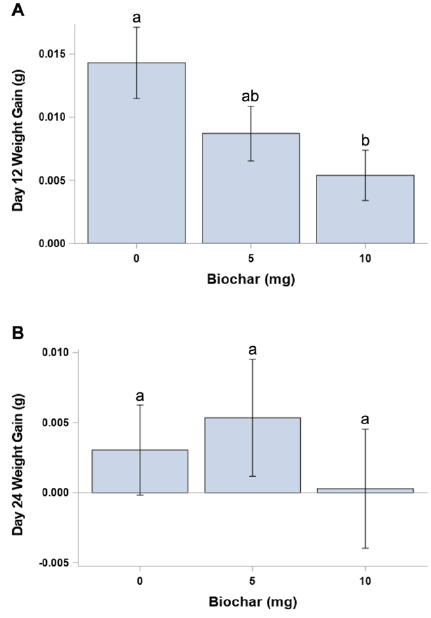
Figure 3. Mean (+ SEM) weight gain at 12 day intervals for individual larvae measured at ( A ) day 12 and ( B ) day 24 for O. pseudotsugata reared on synthetic diet with dry biochar applied to the diet surface at three concentrations (0, 5 and 10 mg). Means with the same letter are not significantly different ( p < 0.05) based upon analysis of variance results.